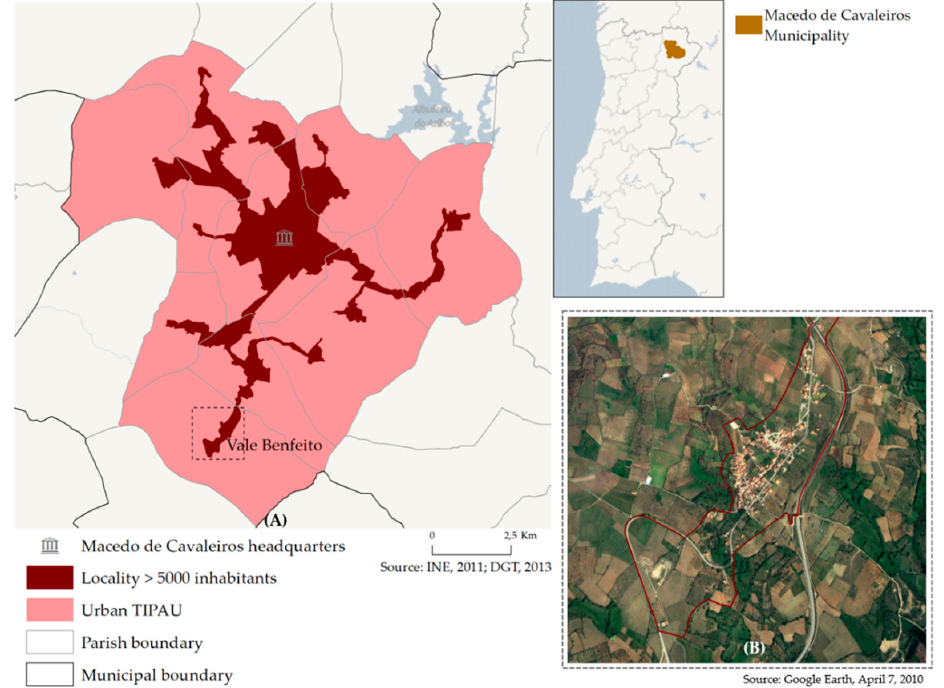
Figure 14. ( A ) Macedo de Cavaleiros locality and the parishes of the municipality of Macedo de Cavaleiros classified as APU (TIPAU); ( B ) Aerial image of Vale Benfeito village. The land use data (COS) shows a minimum level of urbanisation, with only 0.7% of artificialized areas. DEGURBA attributed this parish with Code 3, the opposite extreme. The introduction of the locality and administrative criteria is also responsible for other similar situations not only in this municipality (since the locality containing the headquarters of the municipality is over 5000 inhabitants and spreads over eight parishes), but also in other areas of Continental Portugal. 3.3. Demographic and Socio-Economic Indicators of the Urban Considering the results of the research presented above (section 3.2 ), 10 parishes were analysed, consisting of a subset of the 98 where DEGURBA and TIPAU classifications differ (all of them being Code 3 for DEGURBA and, at the opposite extreme, APU for TIPAU). These 10 parishes also have in common the fact that they were labelled as APU (TIPAU) because all of them partially or totally contain the locality where the headquarters of the municipality is located (the administrative criterion for TIPAU), and all of them have more than 5000 inhabitants. These 10 parishes do not refer to a